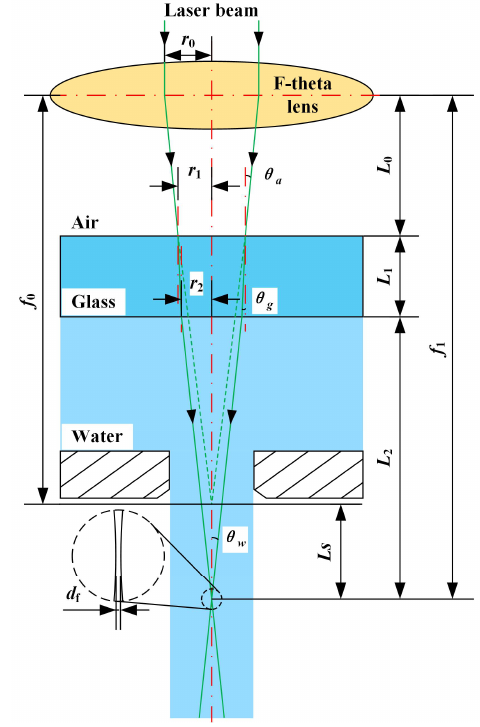
Figure 6. Refraction of the laser beam in quartz glass and water.